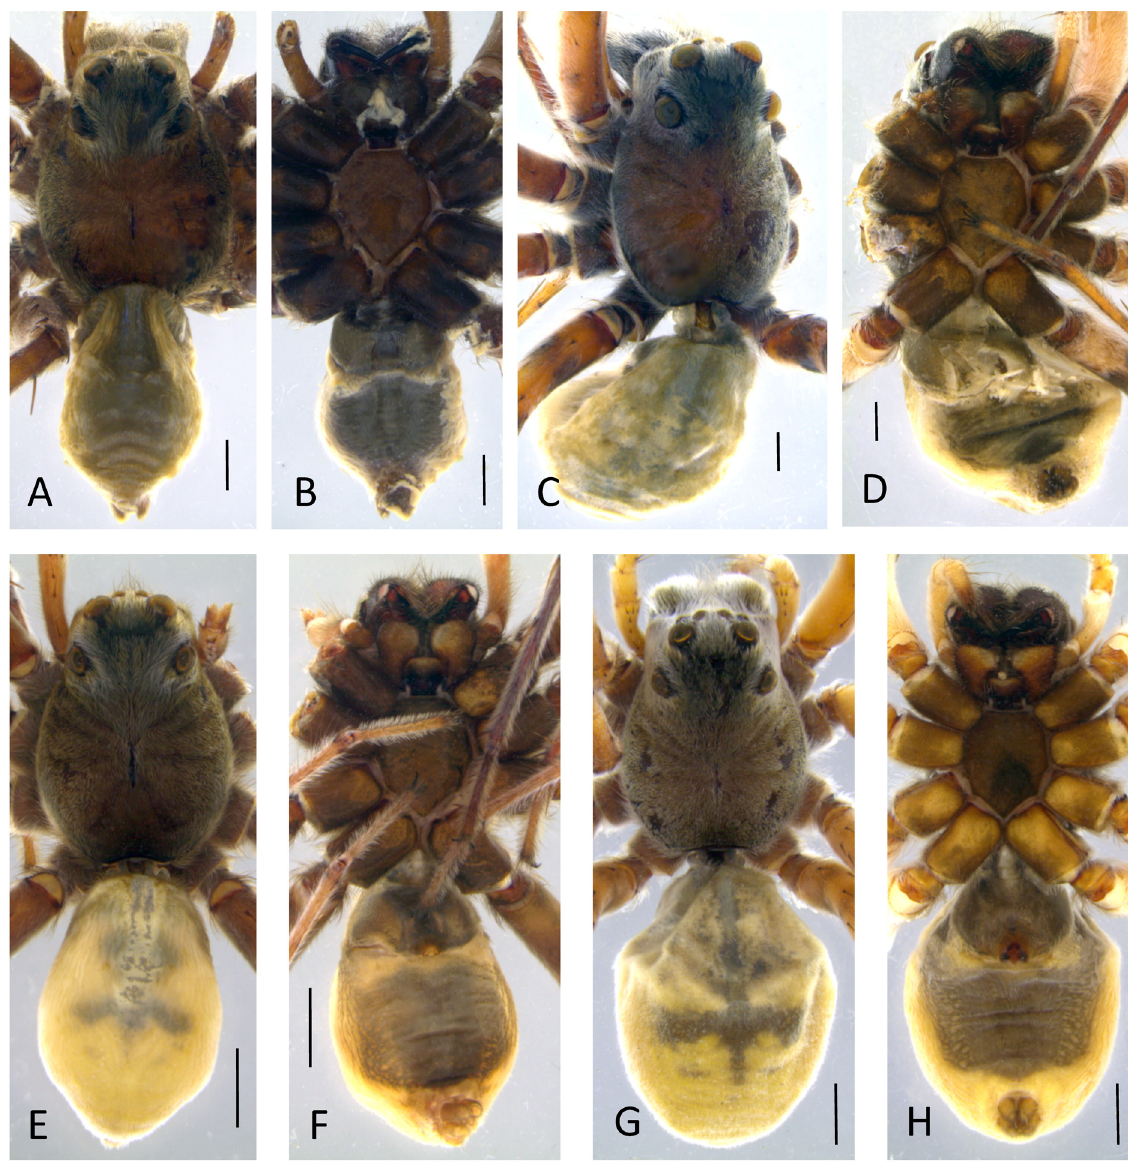
Fig. 22. Tetralycosa Roewer, 1960, microscopic photographs showing dorsal and ventral views. A–B . T. adarca sp. nov. , holotype, ♂ (SAM NN21882). C–D . T. adarca sp. nov. , paratype, ♀ (SAM NN21732). E–F . T. eyrei (Hickman, 1944), ♂ (SAM NN2737). G–H . T. eyrei (Hickman, 1944), ♀ (SAM NN13813). Scale bars: A–H = 2.00